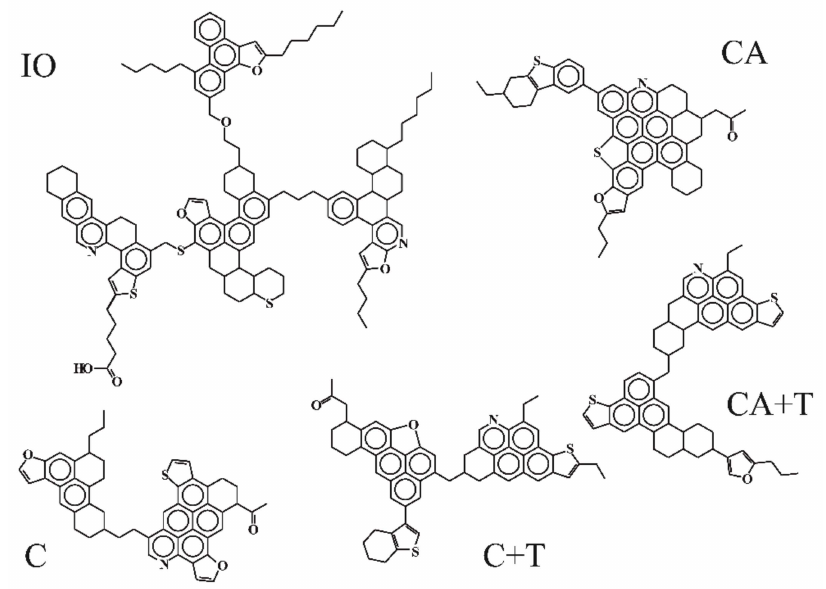
Figure 2. Hypothetical structures of asphaltenes of initial oil and products of